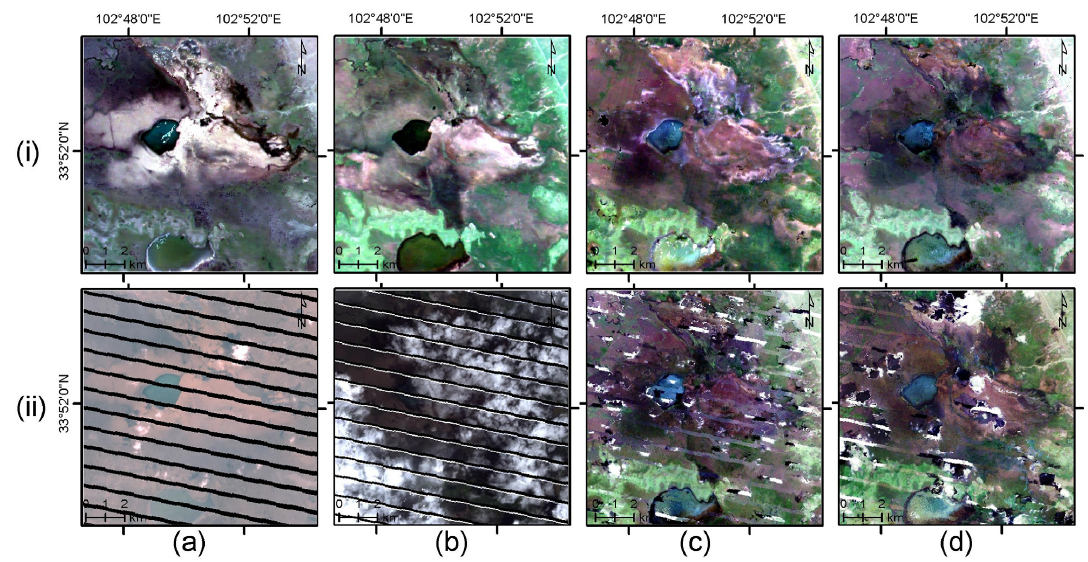
Figure 8. Monthly composited detailed regions of HJ (row ( i )) and WELD (row ( ii )) cropped from Figure 6. ( a – d ) are the enlarged details from May, June, July and August, respectively.